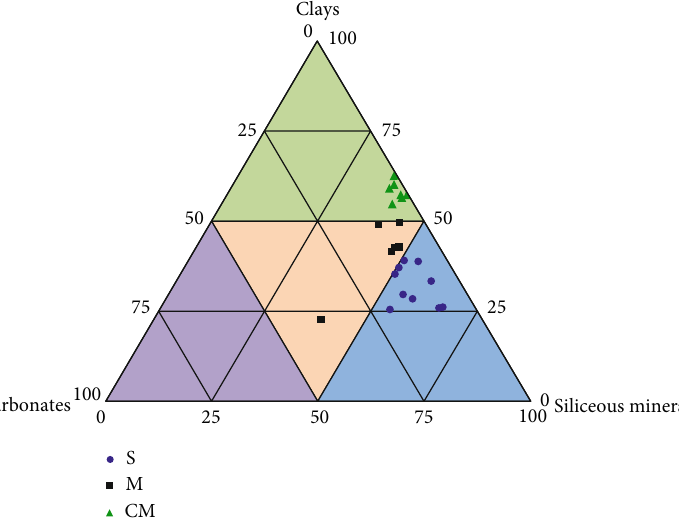
Figure 2: Ternary diagram of the mineralogy of the Silurian shale samples. Shale samples were classi fi ed into three groups: siliceous shale lithofacies (S), argillaceous/siliceous/calcareous mixed shale lithofacies (M), and silica-rich argillaceous shale lithofacies (CM).